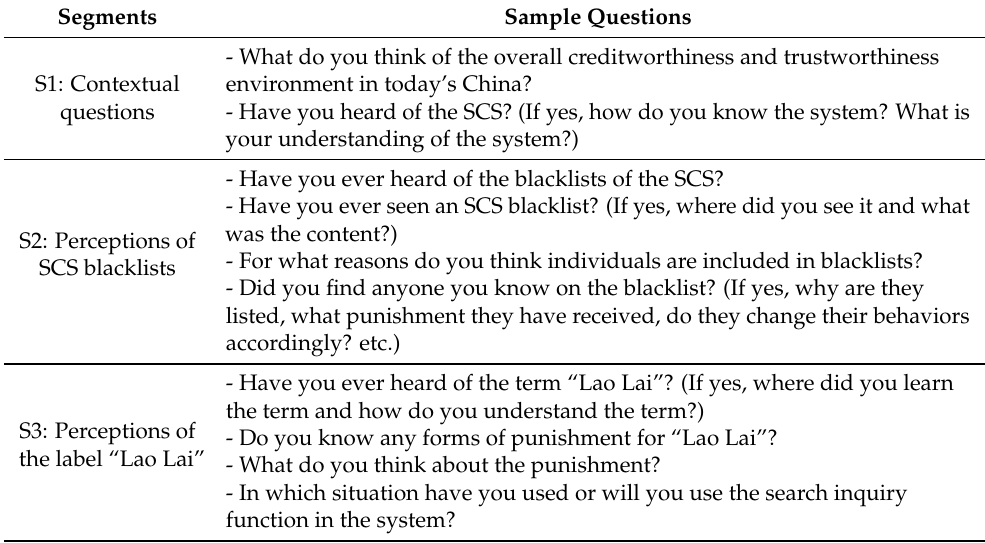
Table 2. Sample interview questions. These questions were translated from Chinese to English for their inclusion in the article. We list part of the interview questions as we followed a semi-structured